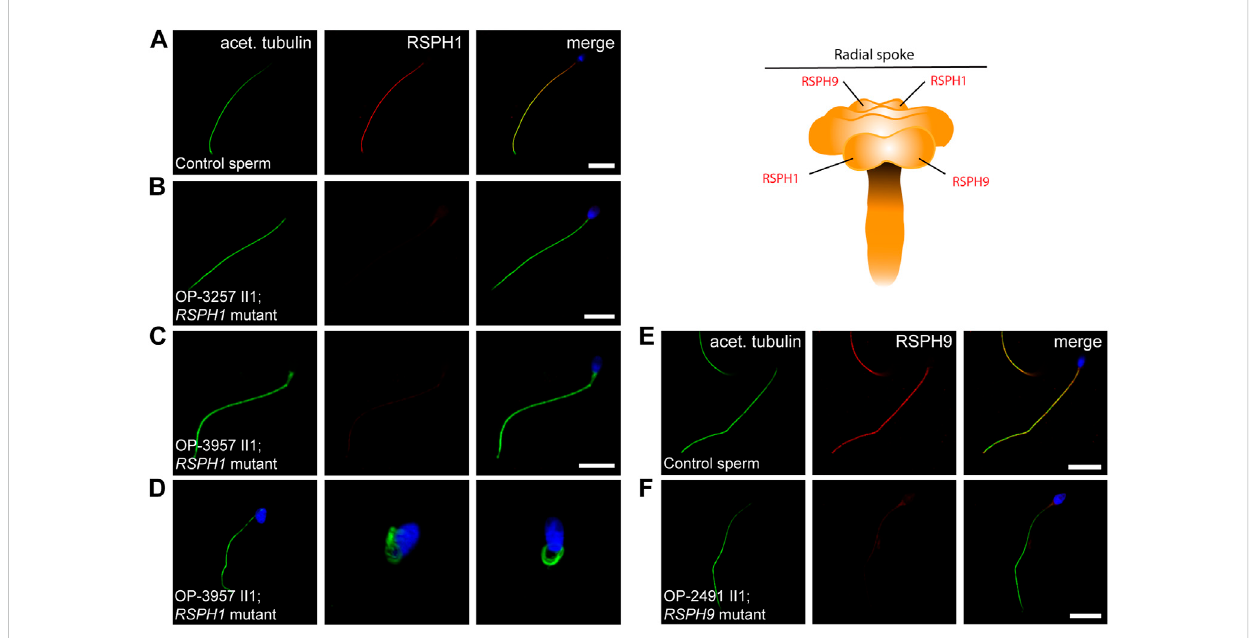
FIGURE 4 RSPH1 and RSPH9 mutationscauseabnormalradialspokeheadcompositioninsperm fl agella.Spermcellsfromhealthycontroldonorsandinfertile male individuals with pathogenic variants in RSPH1 and RSPH9 were co-stained with antibodies directed against acetylated α -tubulin (acet. tubulin; depictedingreen)andRSPH1andRSPH9,respectively(bothdepictedinred). (A) Incontrolspermcells,immunoreactivityagainstRSPH1(red)isobserved alongtheentire fl agellar length. TheRSPH1signal co-localizeswiththe fl agellarmarkeracet.tubulin(depictedinyellow inthemerged image). (B,C) In sperm fl agella of RSPH1 -mutant individuals OP-3257 II1 and OP-3957 II1, a severe reduction of the RSPH1 signal or no signal is observed along the fl agellar axonemes. (D) Sperm cells of RSPH1 -mutant individual OP-3957 II1 display morphological abnormalities, comprising bent fl agella and sperm head defects consistent with MMAF. (E) In control sperm cells, RSPH9 (red) shows a panaxonemal staining pattern and co-localization with the fl agellar marker acet. tubulin (depicted in yellow in themerged image). (F) Incontrast, sperm fl agella of the RSPH9 -mutant individual OP-2491 II1 display a severe reduction ofthe RSPH9 signal. The schematic shows the putative localization of the RSPH1 and RSPH9 proteins in theradial spoke head complex. Nuclei were stained with Hoechst33342. Scale bars represent 10